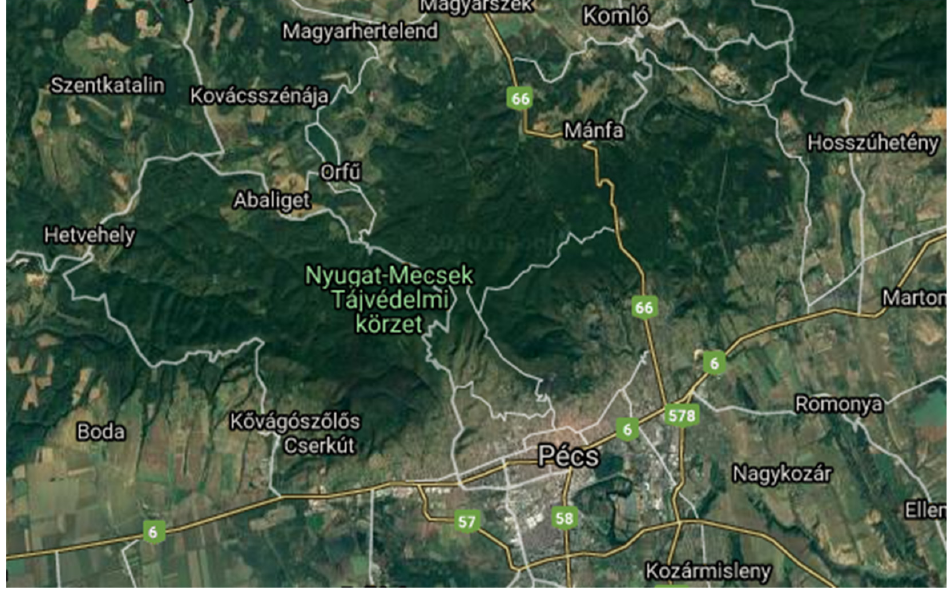
Figure 1. The study site in the Mecsek medium mountains, north of Pécs, the location of the University of Pécs (source: Google Maps).